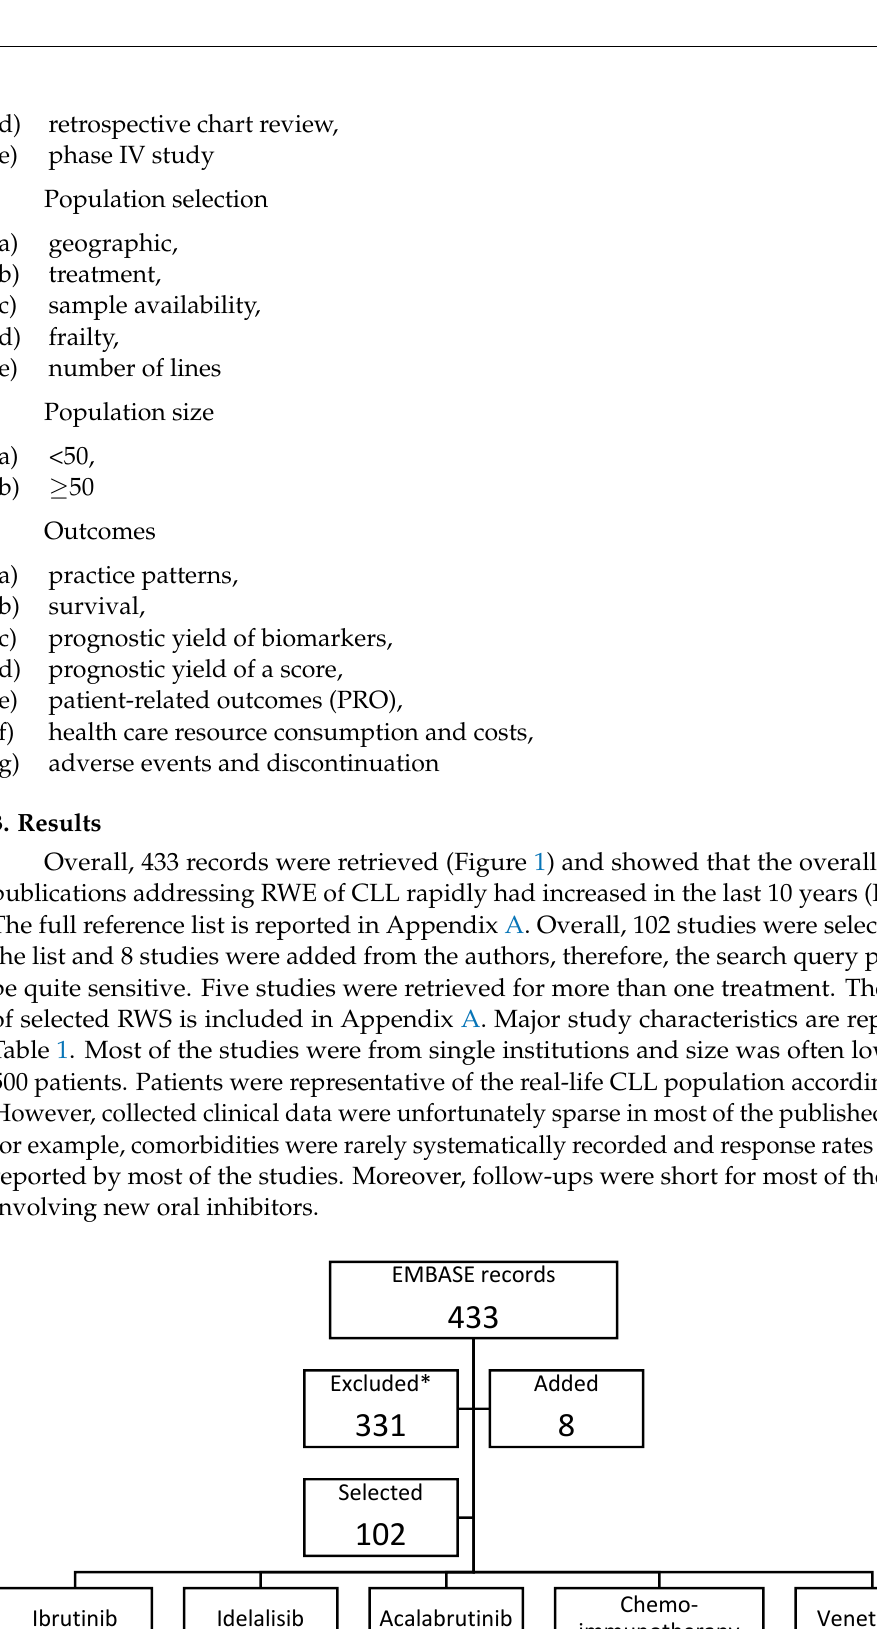
Figure 2. Publication trends of RWS. Distribution of the 433 retrieved RWS according to the year of publication. Only 1 phase IV study was reported by Moreno, C. et al. [7]; the study reported the outcomes of 103 patients treated with ofatumumab monotherapy after a median of four prior lines. The study reported a 5-month progression-free survival (PFS) and 11-month overall survival (OS), thus, confirming the data of the published randomized trial comparing ibrutinib versus ofatumumab.